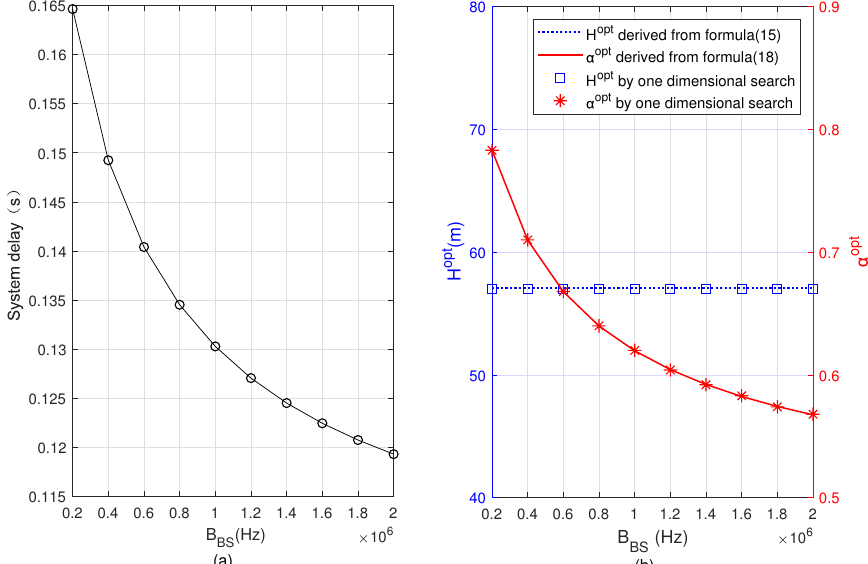
Figure 5. Minimum system delay, optimal flying altitude, and optimal task allocation ratio versus bandwidth allocated to BS for task offloading. ( a ) Minimum system delay, ( b ) optimal flying altitude and optimal task allocation ratio.